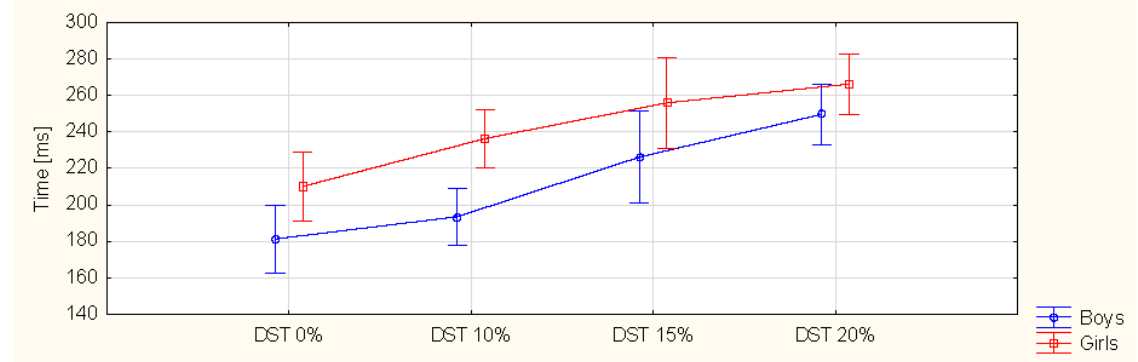
Figure 5. Double ‐ support ‐ time (DST) values for different BP loads. Figure 5. Double-support-time (DST) values for different BP